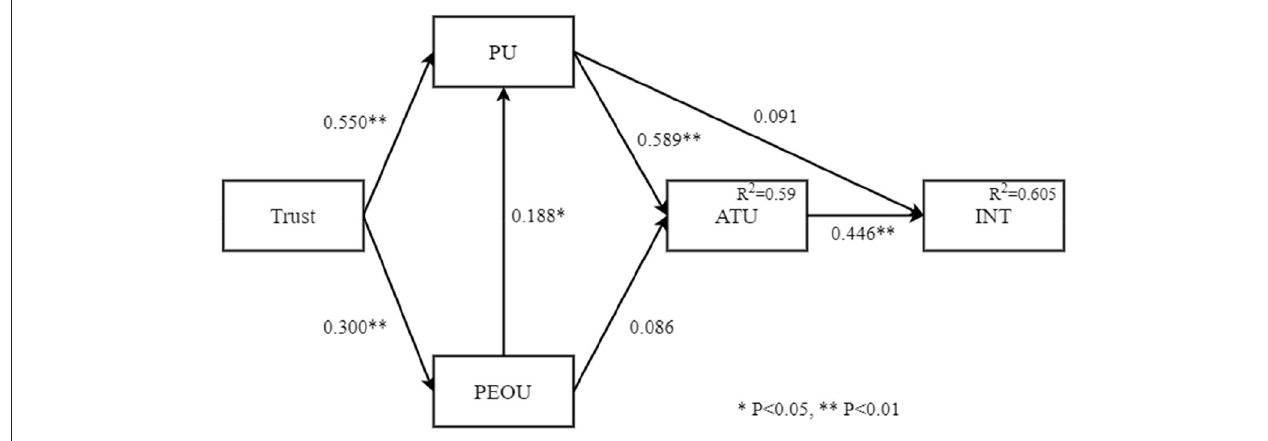
FIGURE 1 | The path analysis of research model ( N =